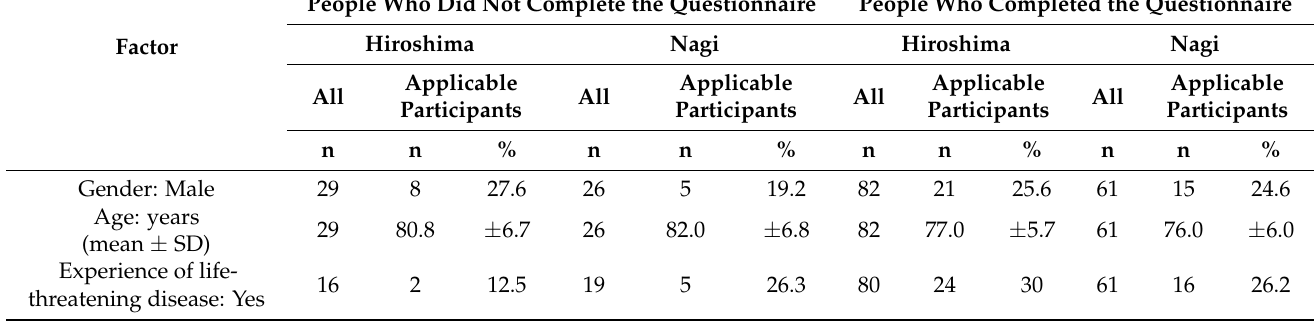
Table 1. Comparison between people who did not complete the questionnaire and people who completed the